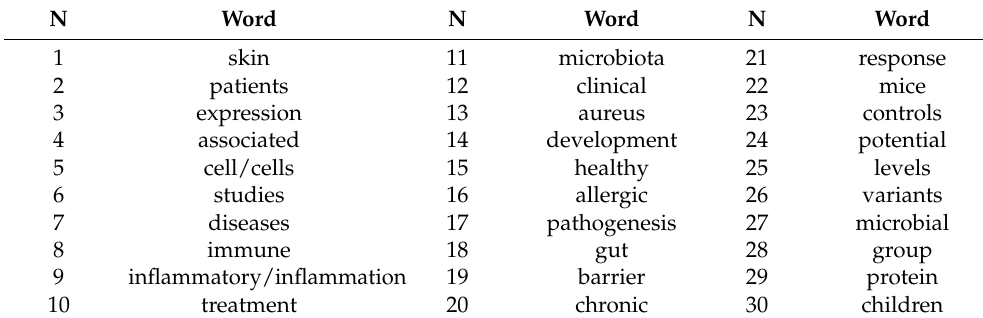
Table 2. The top 30 cited atomization results from the omics literature concerning skin diseases with alterations in the Notch signaling